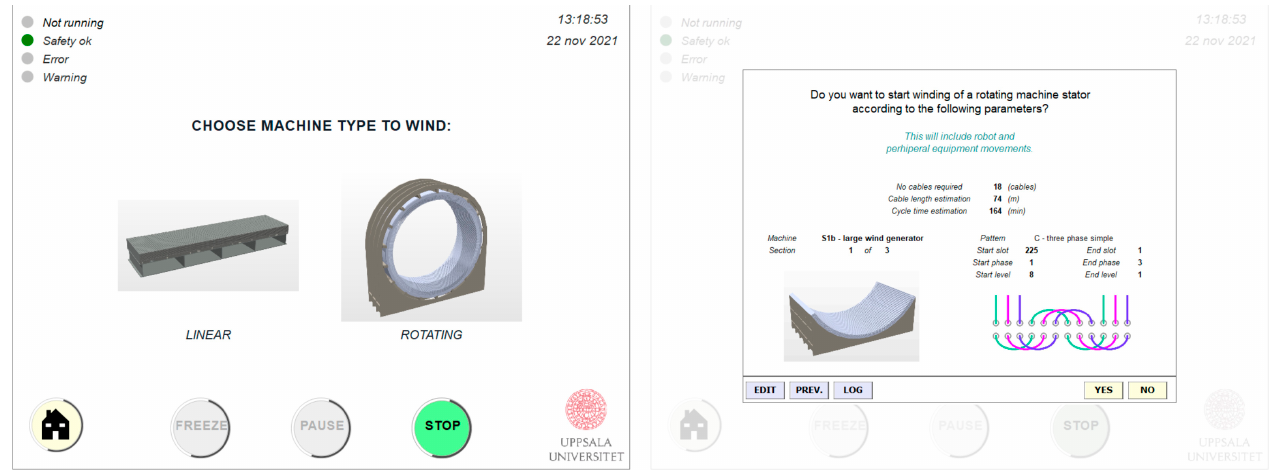
Figure 15. Illustrated extension to rotating stator designs of the GUI previously implemented on an operator touch screen for control, supervision and service of the robot stator cable winding process.